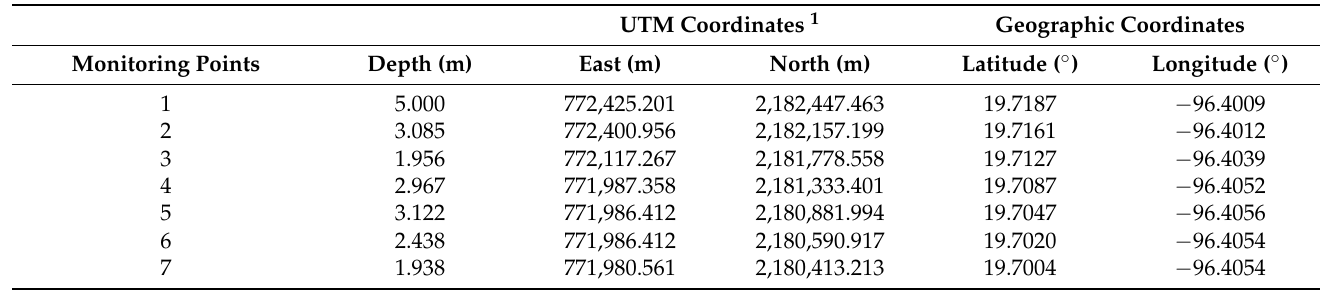
Table 1. Location of monitoring points.